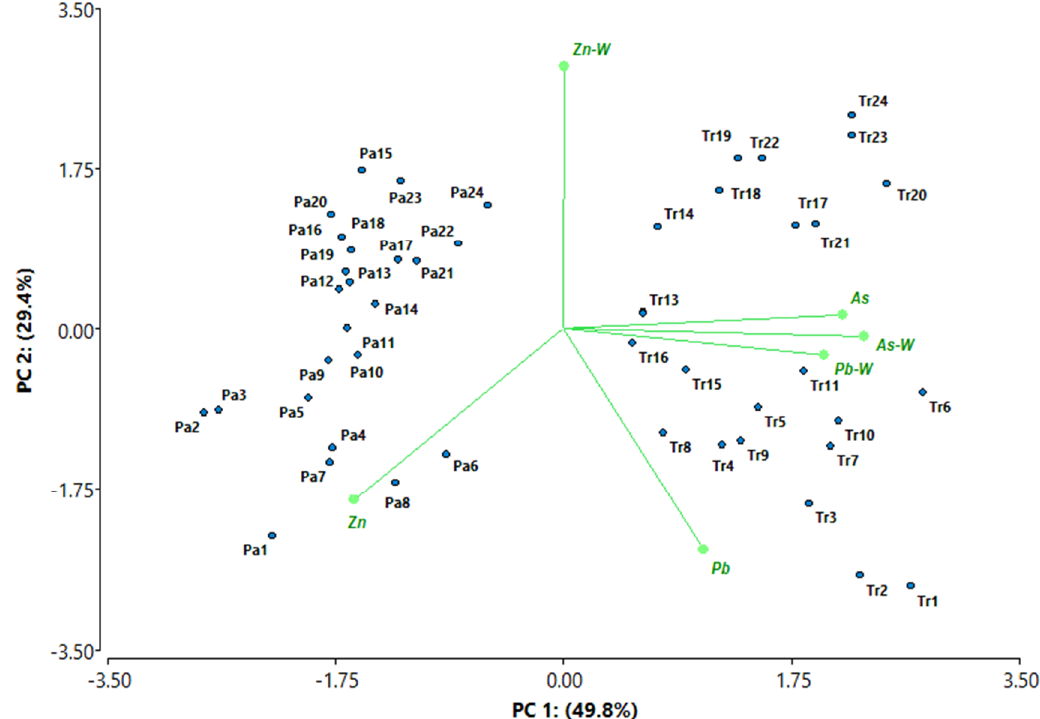
Figure 6. Principal component analysis based on the concentrations of toxic metals in the sediments and water samples of the Paca Lagoon (Pa) and Tragadero Lagoon (Tr). Metals with “-W” represent the concentration of metal in the water surface samples.